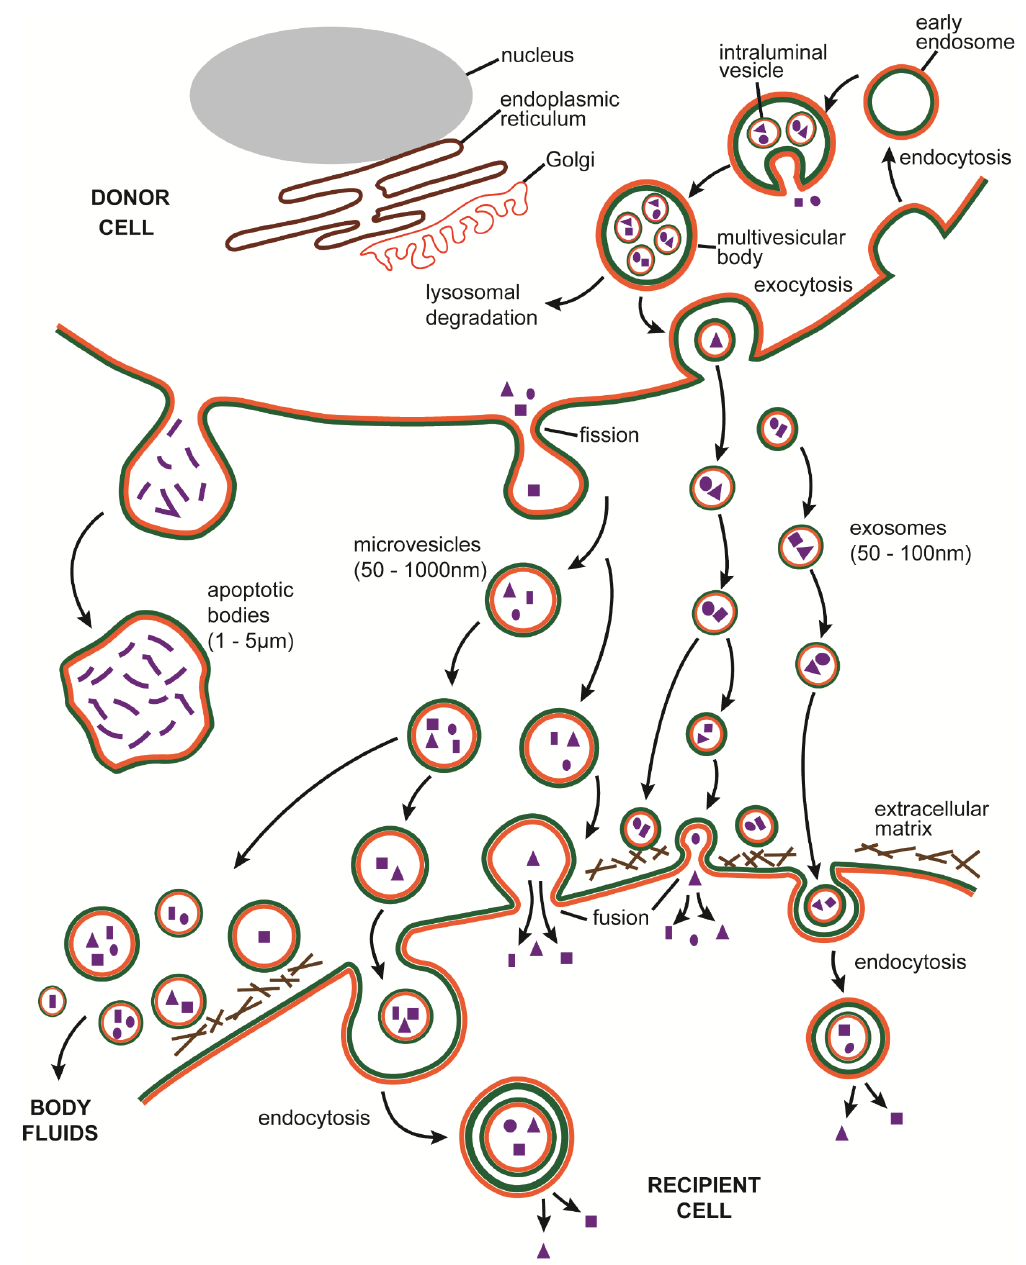
Figure 2. Pathways of EV biogenesis and action. Three type of EVs are produced by most cells. Exosome biogenesis is initiated by the involution and pinching off of the endosomal membrane resulting in the production of an ILV that contains cytoplasmic constituents. As ILVs accumulate, MVBs are generated, which are then either degraded via the lysosomal pathway or trafficked to the cell surface whereupon they fuse with plasma membrane and liberate their contents, now becoming exosomes, into the extracellular space. Mircovesicles also contain similar cytoplasmic constituents but are generated by fission of the plasma membrane. Apoptotic bodies contain components of cell degradation and form by cytoplasmic bulging and separation from the cell as a result of cytosketetal breakdown during cell disassembly. Microvesicles and exosomes may bind to ECM components in the interstitial space or may be internalized by target cells, either by fusion with the plasma membrane or by endocytosis, both of which result in delivery of their respective molecular payloads into the recipient cell. Once released into the extracellular space, EVs may alternatively be carried in interstitial fluids into the main body fluids allowing them to target cells at distant sites or to be